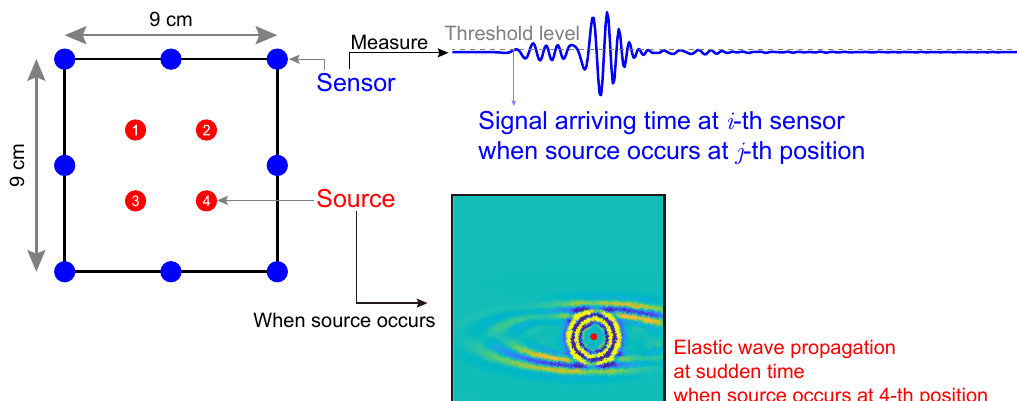
Figure 4. Numerical experiment setting for solving Equation (8). When the source is at the red dot (position 4), an elliptical acoustic wave propagates, and the signal is measured at the blue